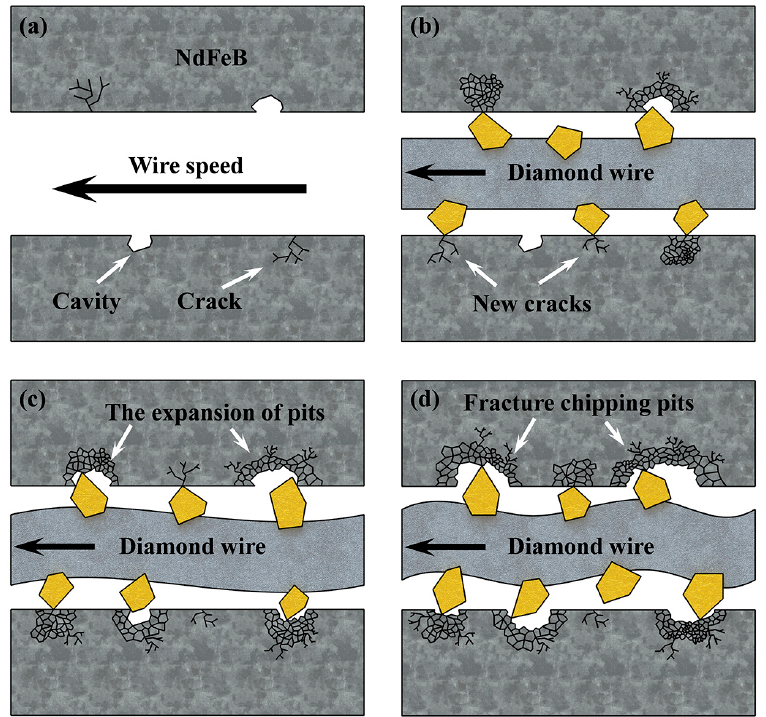
Figure 15. ( a ) Original surface of the NdFeB; ( b – d ) are the vicious circle between wire vibration and fracture chipping.